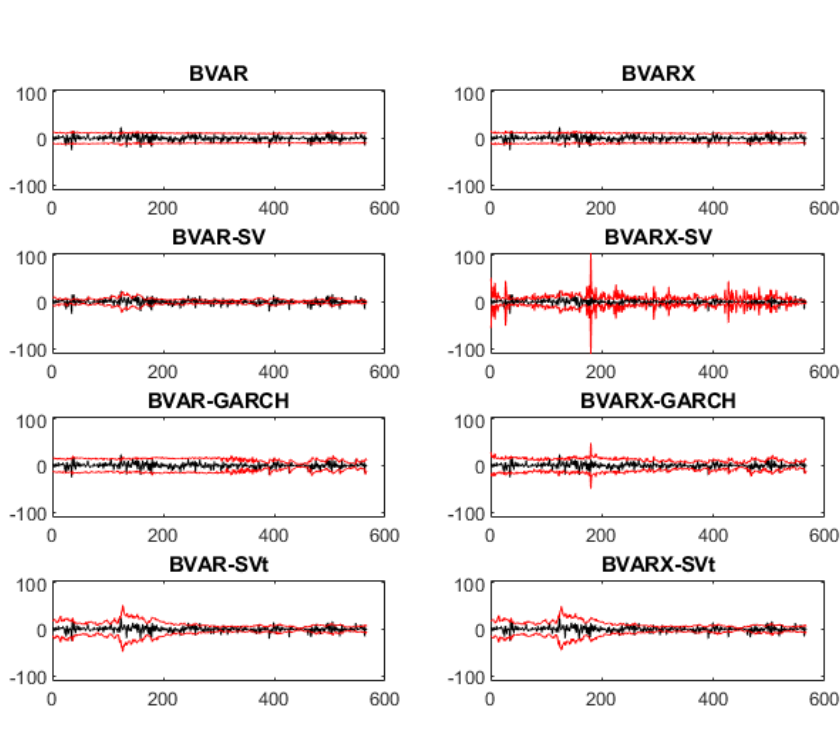
Figure A1. Credible interval for Bitcoin.